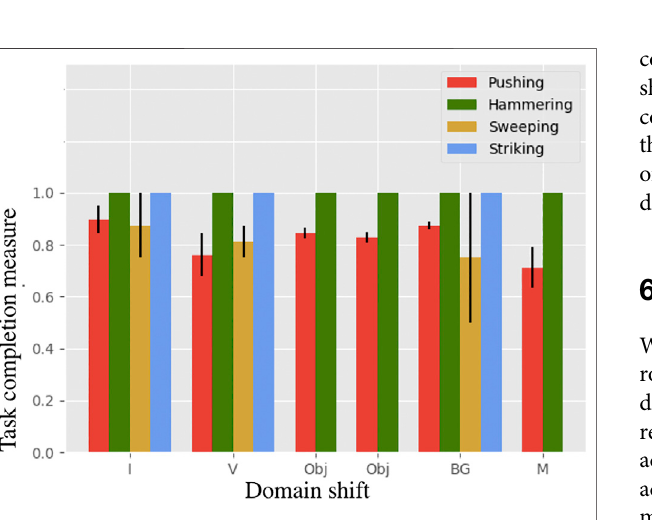
FIGURE 9 | Task completion measures for the task of pushing, hammering, sweeping and striking in the real robot experiment. The result shows that O 2 A performs well under different domain shifts on a real